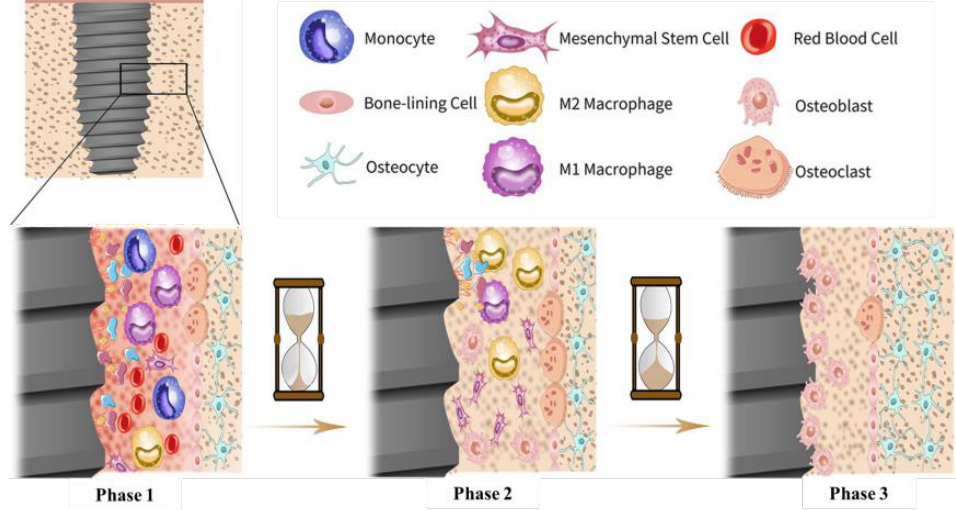
Figure 4. The osseointegration procedure on metallic implants [71]. In phase 1, the surface is surrounded by blood, biomolecules, proteins, glycoproteins, and lipids, establishing a bioactive film. In phase 2, the initial bone tissue absorption is begins simultaneously with osteon cells’ proliferation and differentiation, leading to mineralization. In phase 3, the surface is covered by osteoblasts and osteoclasts, causing progressive osteointegration.